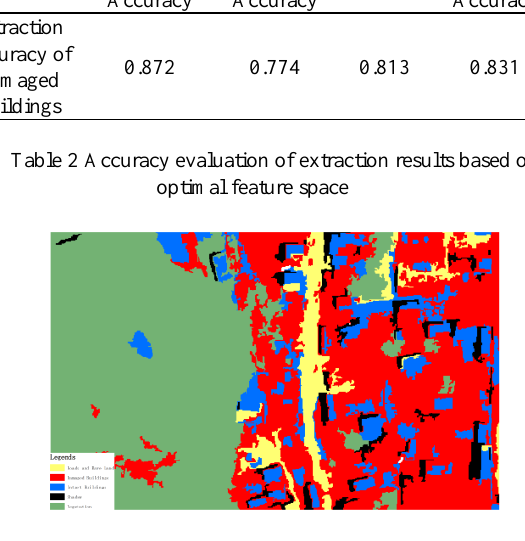
Figure 5 Extraction results based on optimal feature space